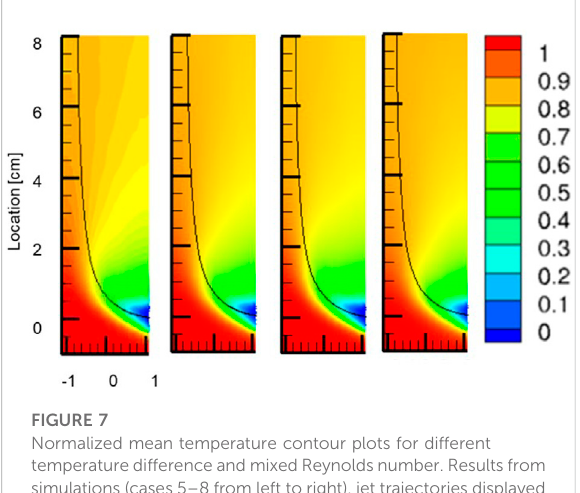
FIGURE 7 Normalized mean temperature contour plots for different temperaturedifference and mixed Reynolds number. Results from simulations (cases 5 – 8 from left to right), jet trajectories displayed with solid black